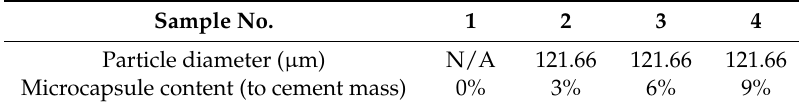
Table 2. Mix proportions of